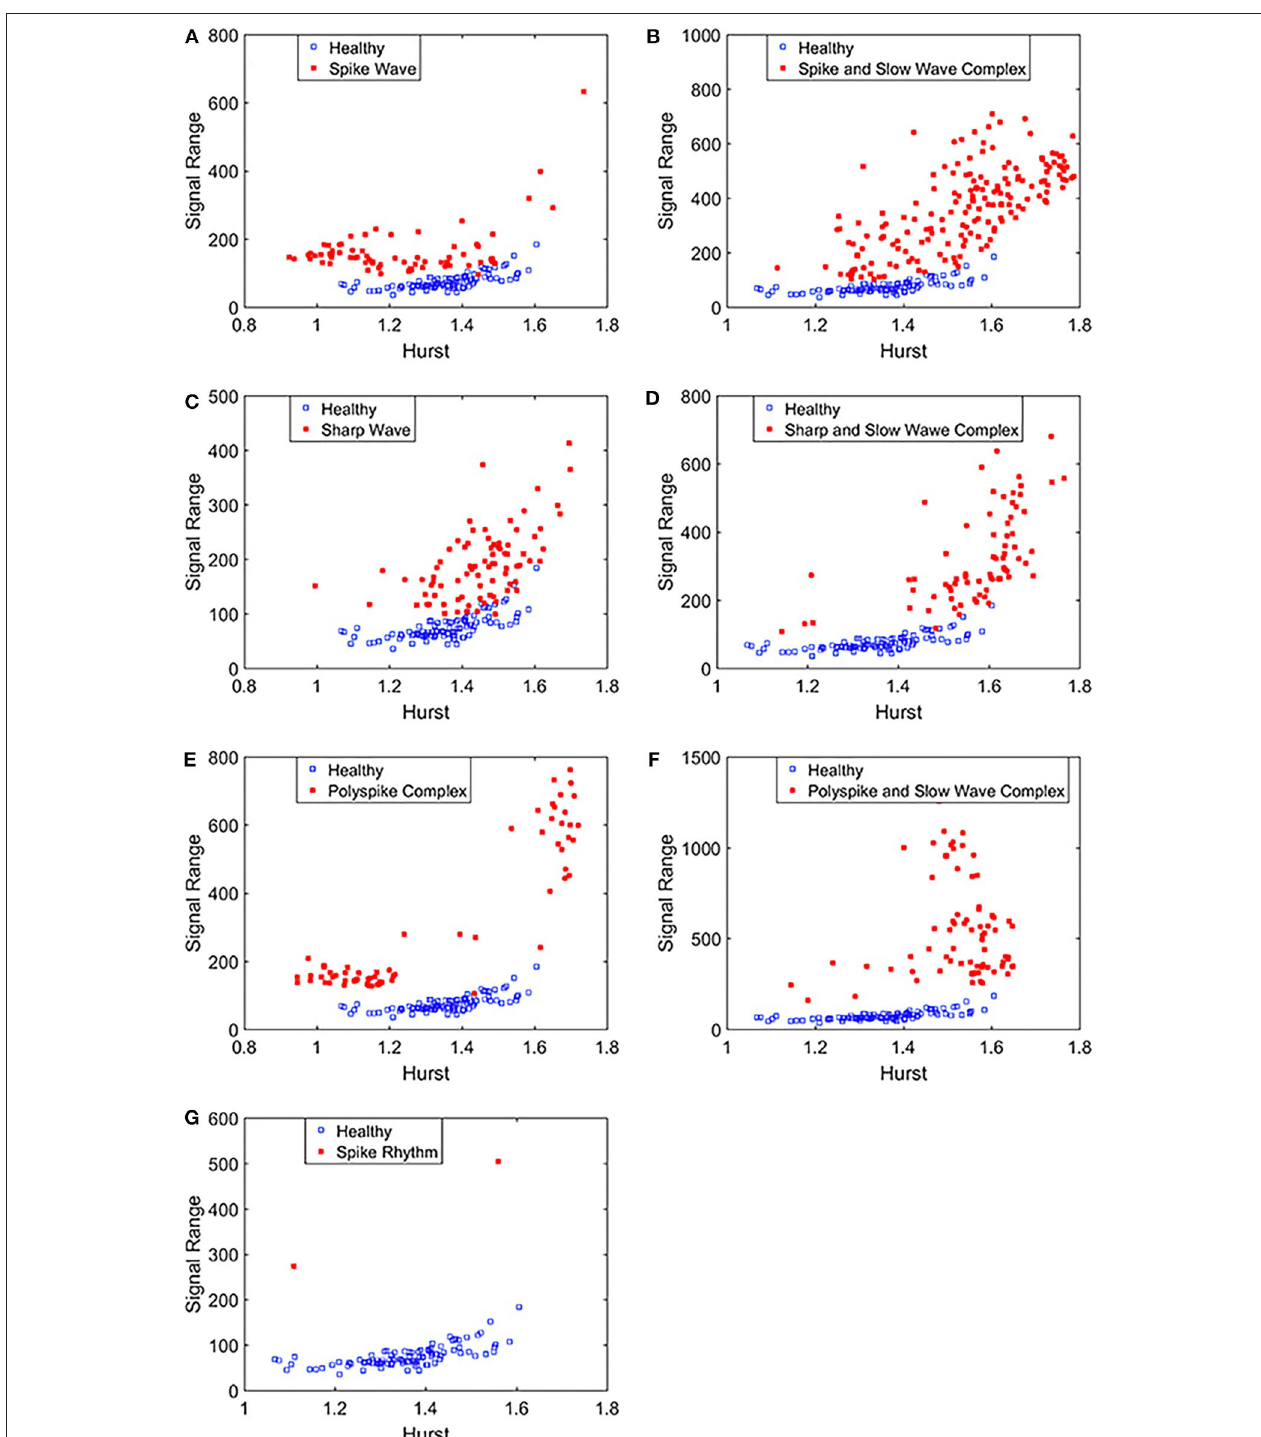
FIGURE 5 | Scatter plots using features Signal Range and the Hurst parameter H , where (A–G) , illustrates the different between the seven types of epileptiform discharges (spike wave, spike and slow wave complex, sharp wave, sharp and slow wave complex, polyspike complex, polyspike and slow wave complex, spike rhythm discharges) and normal EEG. These plots highly suggest the classification accuracy will be very high.